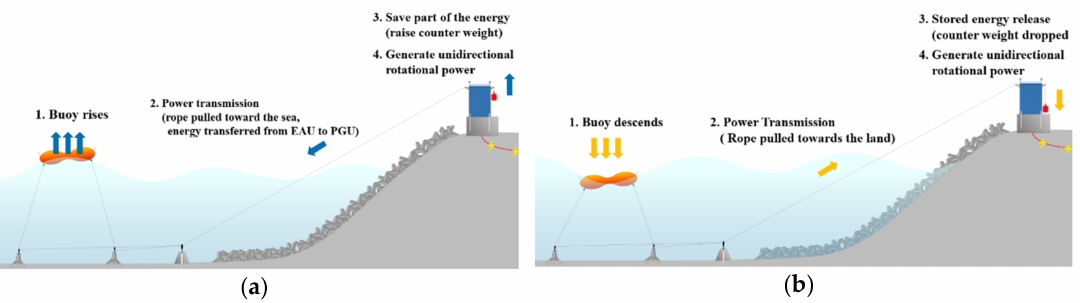
Figure 2. Working principle of the nearshore WEC [13] ( a ) when the buoy rises and ( b ) when the buoy